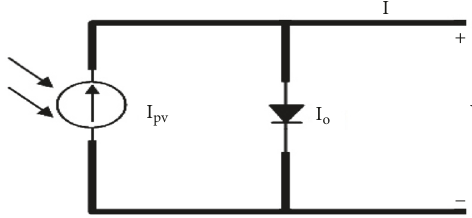
Figure 2: Simplified or Ideal equivalent circuit of a PV cell.